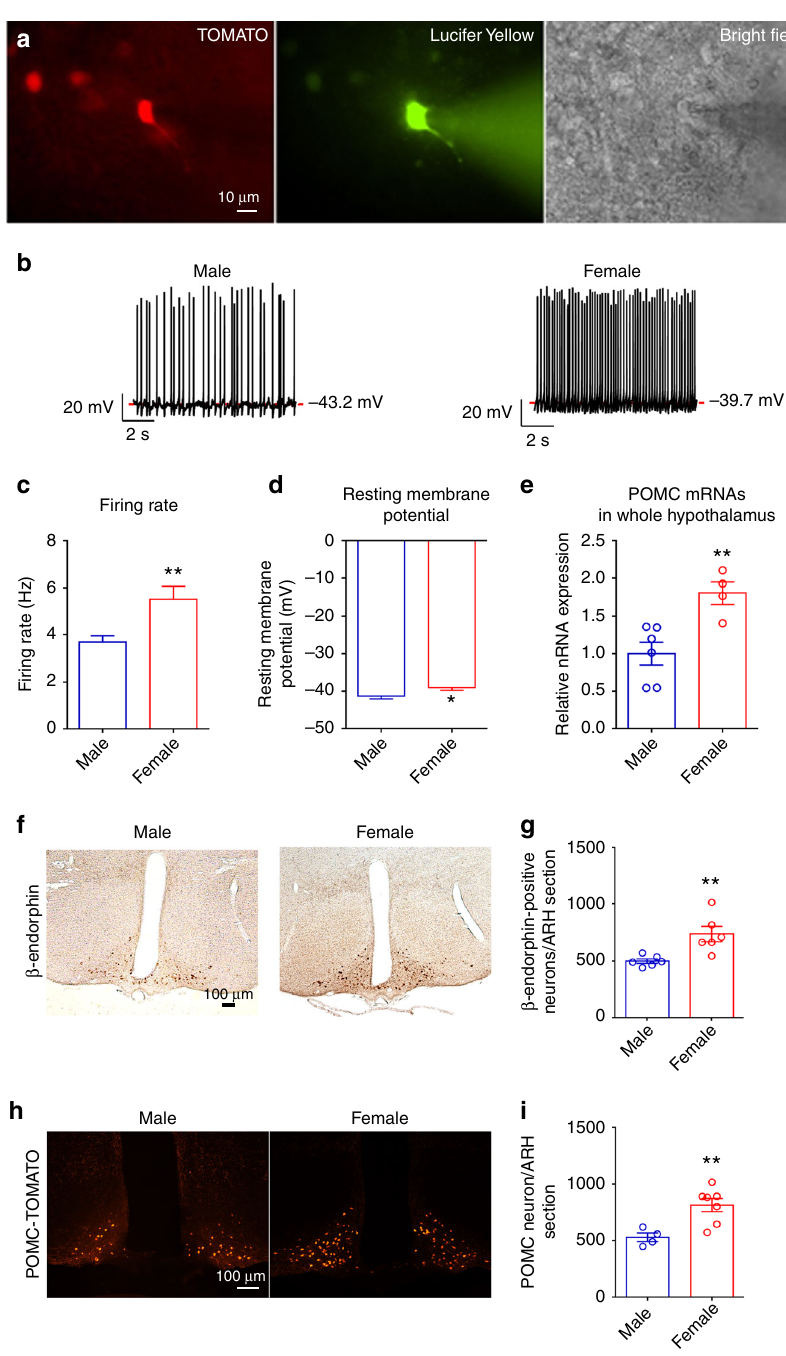
Fig. 1 POMC neurons display sexual dimorphism in neural activities and gene transcription. a Fluorescence for TOMATO (left) and Lucifer Yellow (middle), and bright- fi eld illumination (right) of the recorded POMC neuron in a brain slice prepared from POMC-CreER T2 /Rosa26-tdTOMATO mouse with tamoxifen induction at 11 weeks of age. b Representative current clamp traces in POMC neurons from chow-fed male or female POMC-CreER T2 /Rosa26-tdTOMATO mice at the age of 15 – 16 weeks. c , d Average fi ring rate ( c ) and resting membrane potential ( d ) in POMC neurons from male or female POMC-CreER T2 / Rosa26-tdTOMATO mice. Data are presented as mean ± SEM. N = 37 – 78 per group. * P < 0.05 or ** P < 0.01 in t -tests. e POMC mRNAs levels in the entire hypothalamus from male or female littermates (16 weeks of age), quanti fi ed by RT – qPCR. Data are presented as mean ± SEM with individual data points. N = 4 or 6 per group. ** P < 0.01 in t -tests. f Representative immunostaining images for β -endorphin in the hypothalamus of male or female littermates (16 weeks of age). g Quanti fi cations of β -endorphin-positive neurons in the hypothalamus from 1 out of fi ve consecutive brain sections of male or female littermates. Data are presented as mean ± SEM with individual data points. N = 6 per group. ** P < 0.01 in t -tests. h Representative fl uorescent images for TOMATO in the hypothalamus of male or female POMC-CreER T2 /Rosa26-tdTOMATO littermates (tamoxifen injected at 11 weeks of age, and perfused at 16 weeks of age). i Quanti fi cations of TOMATO-positive neurons (POMC neurons) in the hypothalamus of one out of fi ve consecutive brain sections of male or female littermates (tamoxifen injected at 11 weeks of age, and perfused at 16 weeks of age). Data are presented as mean ± SEM with individual data points. N = 4 or 7 per group. ** P < 0.01 in t